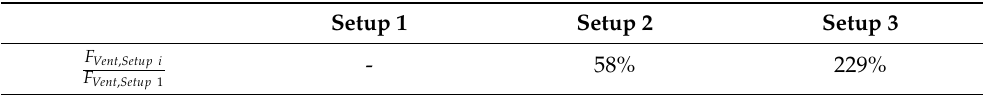
Table 4. Total ventilation drag of the different HDV setups F Vent , Setup i from Figure 12 referenced to the setup 1 F Vent , Setup 1 in percentage.